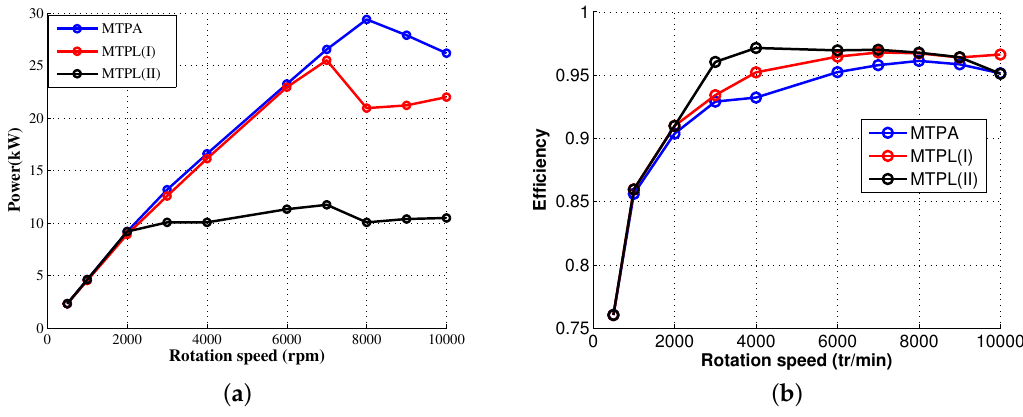
Figure 10. ( a ) Power versus speed; ( b ) Efficiency versus